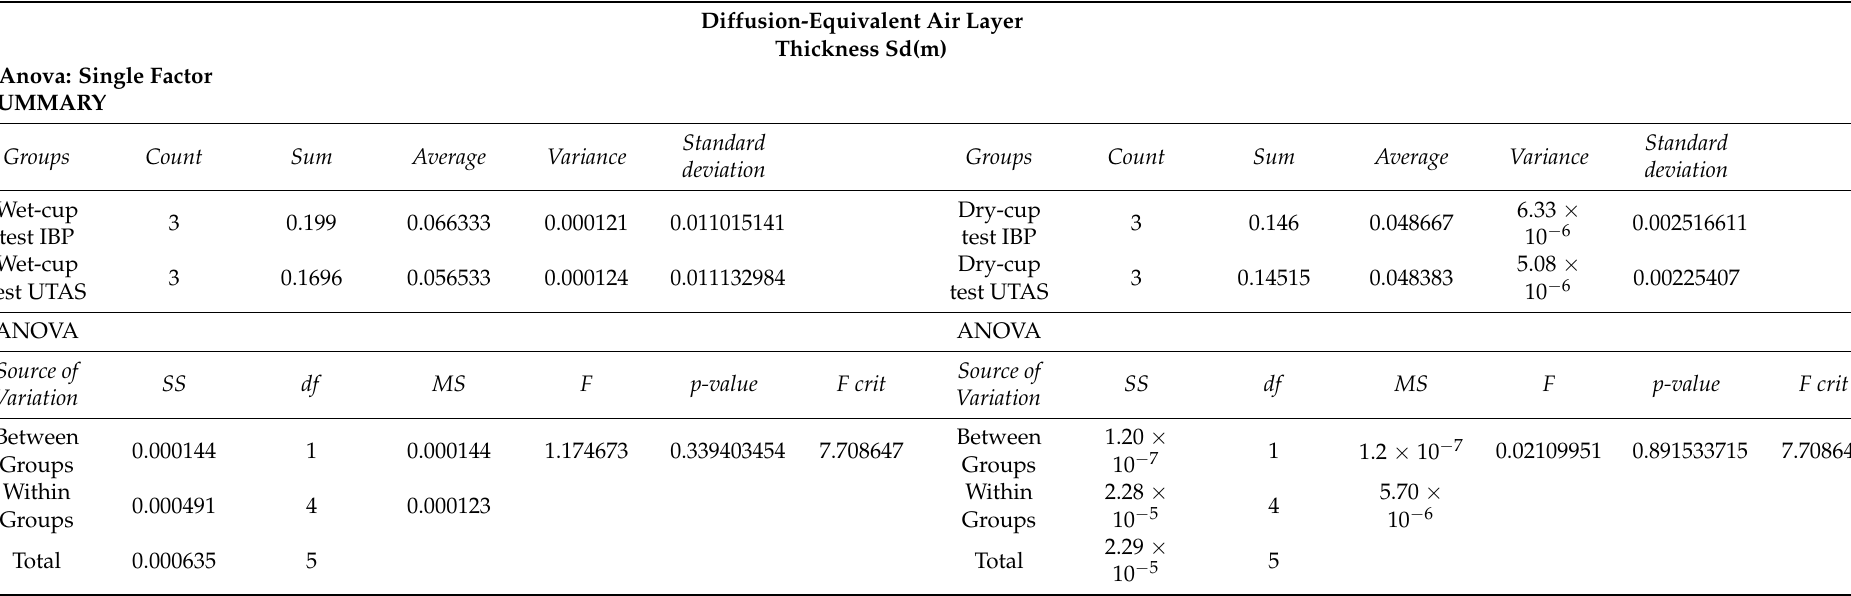
Table 6. Inter-laboratory comparison of the ANOVA result for the diffusion-equivalent air layer thickness Sd(m) of dry-cup